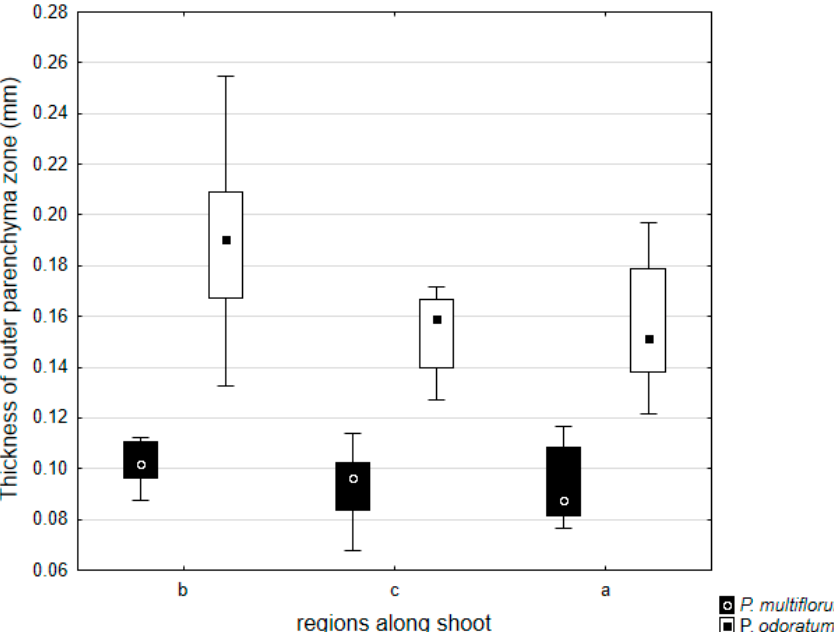
Figure 3. Thickness of outer parenchyma zone at basal (b), central (c) and apical (a) regions along shoot of both species.